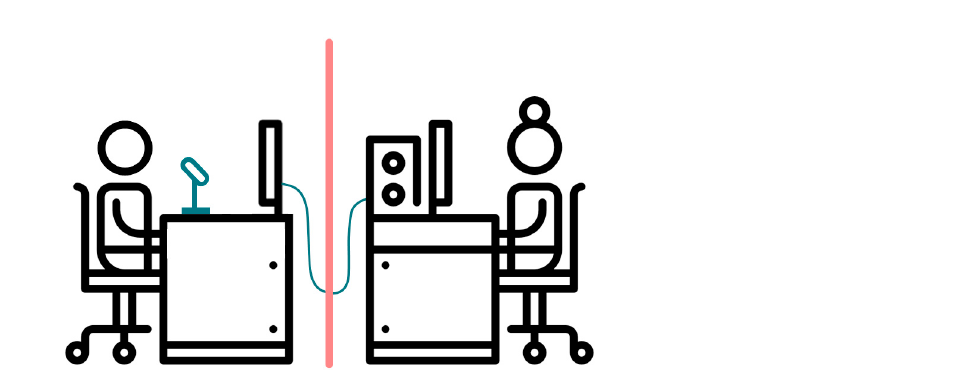
Figure 7. Configuration of the scenario for the Wizard of Oz experiment (figure from the authors, designed using resources from [40]).